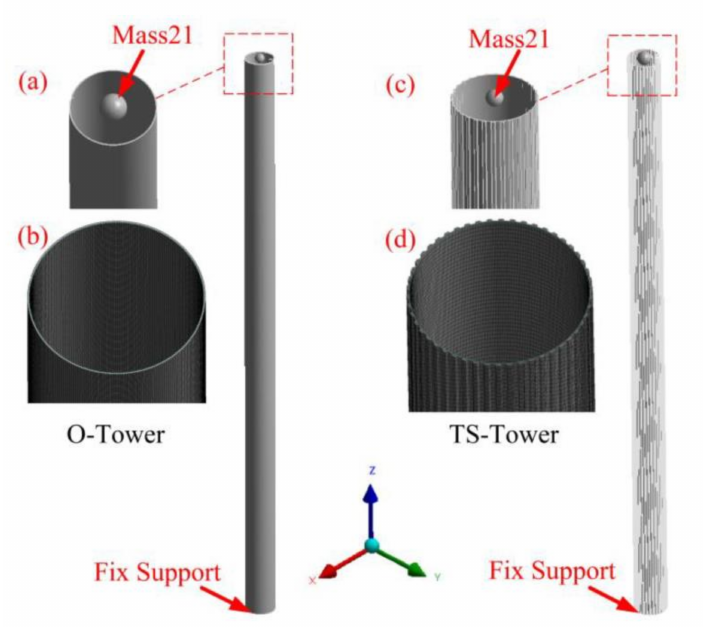
Figure 14. Simplified model of wind turbine towers for the modal analysis: ( a , c ) The boundary condition view of O-Tower and TS-Tower; ( b , d ) The element view of O-Tower and